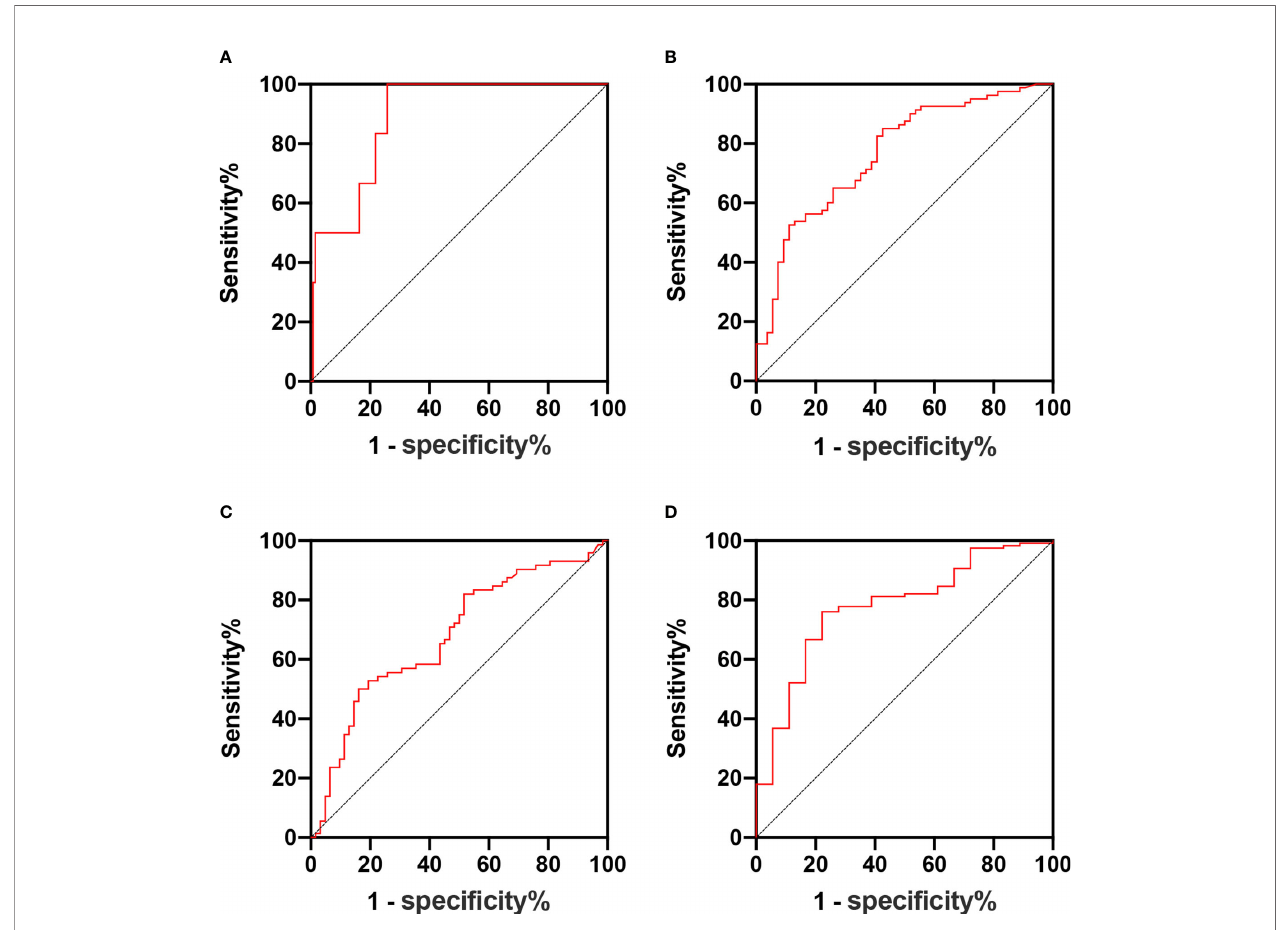
FIGURE 3 | (A – D) Receiver operating characteristic curve of the predictive values of the tumor volume for parametrial in fi ltration (A) , deep cervical in fi ltration (B) , lymph vascular space invasion (C) , and high-risk patients (D)